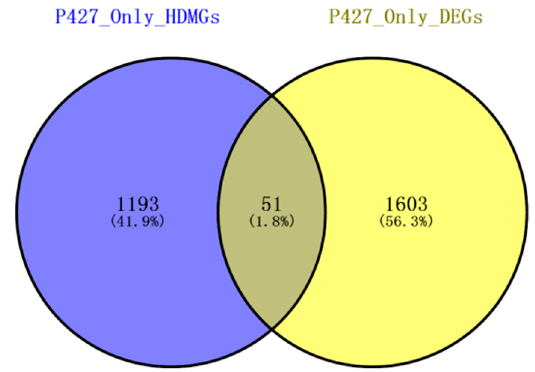
Figure 6. Diagram of P427-specific differentially expressed genes and hypermethylation differentially expressed genes in the promoter region.